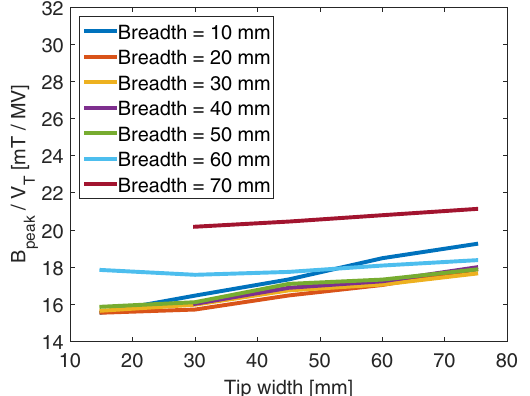
=V FIG. 5. B T vs base width for different values of base peak breadth. The tip width and breadth were fixed at 45 mm and 40 mm, respectively.